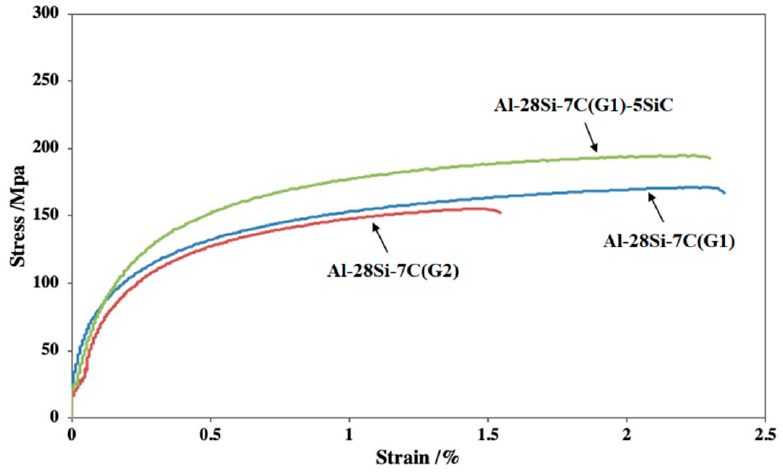
Figure 8. Tensile stress-strain curves of the SiC/AMCs.